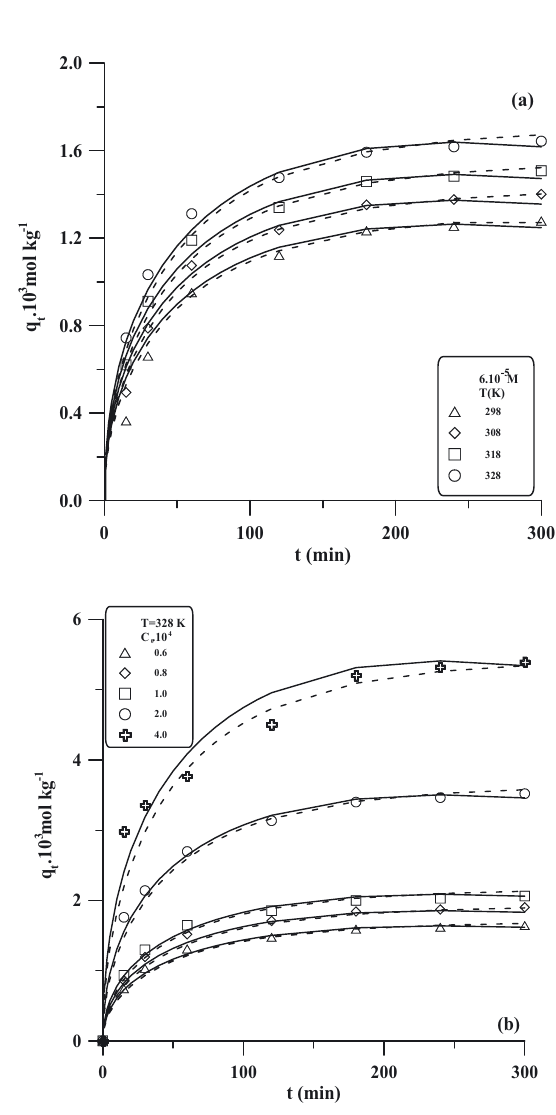
Figure 5. a) Time dependencies of adsorbed amounts in 6.0 × 10 -5 M MCPA solutions at different temperatures, b) time de- pendencies of adsorbed amounts in various initial con- centration of MCPA at 328 K. (Solid and dashed curves have been calculated using Paterson and Nernst-Planck models,